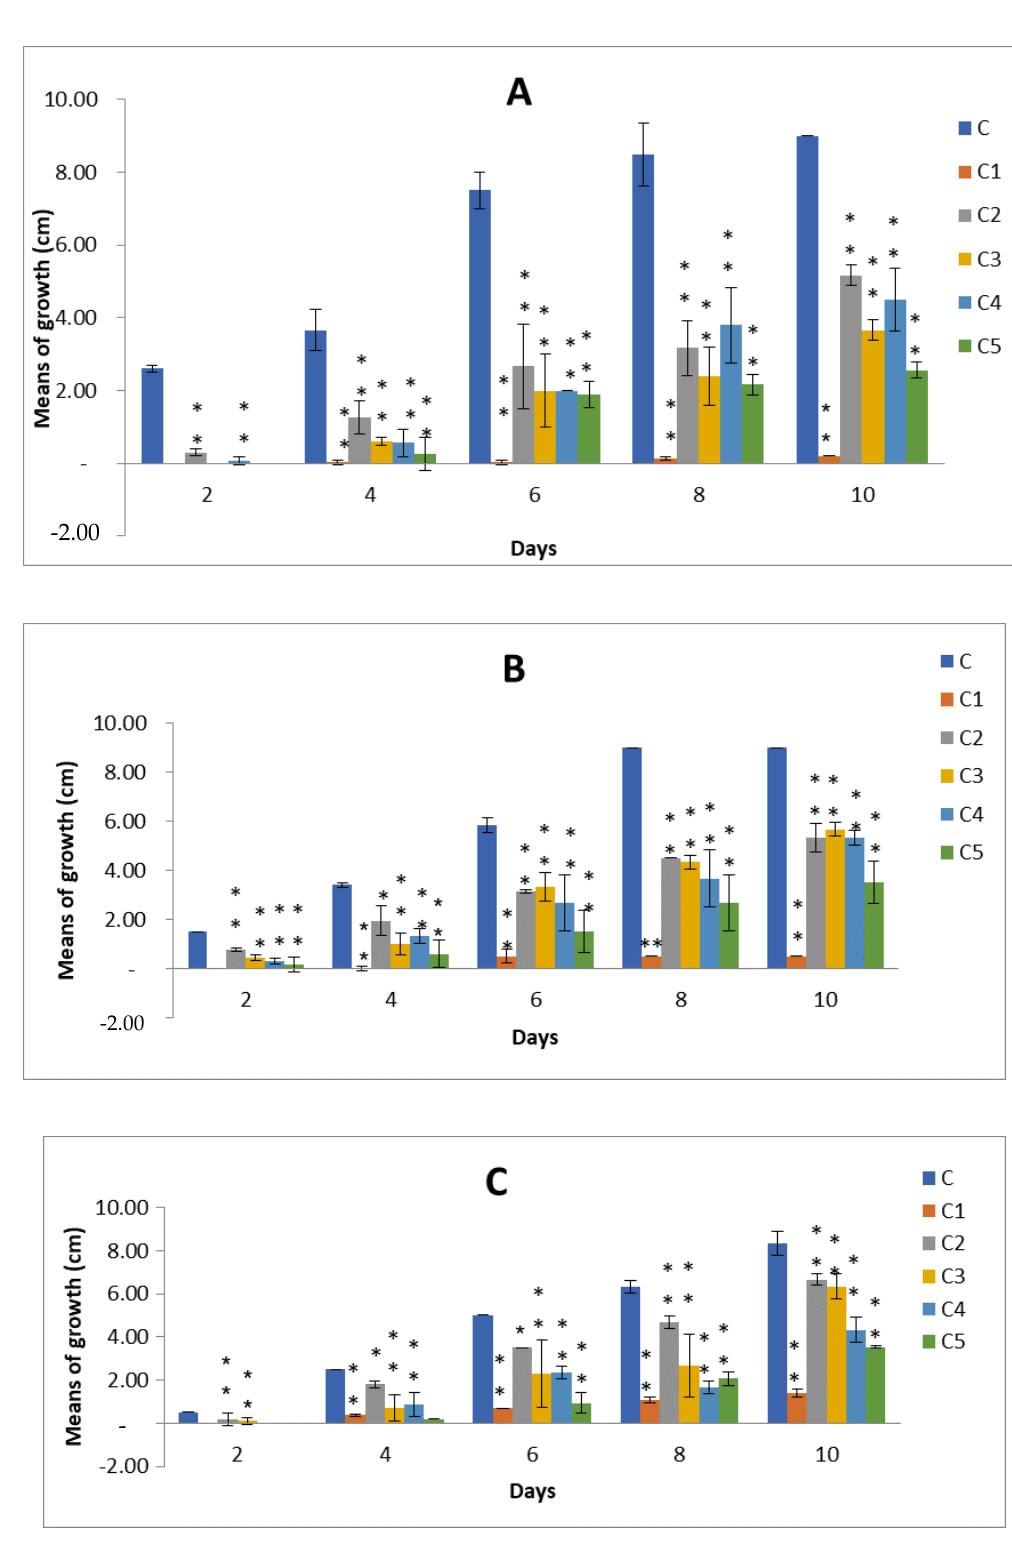
Figure 4. Antifungal activity of fruits extract of Zizyphus spina-christi L. against ( A ) A. alternate , ( B ) A. citri, and ( C ) A. radicina at different concentrations: C is control, C1 Mancozeb, C2 50 mg/mL, C3 100 mg/mL, C4 150 mg/mL, and C5 200 mg/mL. Values are means of three replicates ± standard deviation. Statistical significance of differences compared to control: * Significant at p > 0.05, ** Significant at p < 0.01 according to Duncan